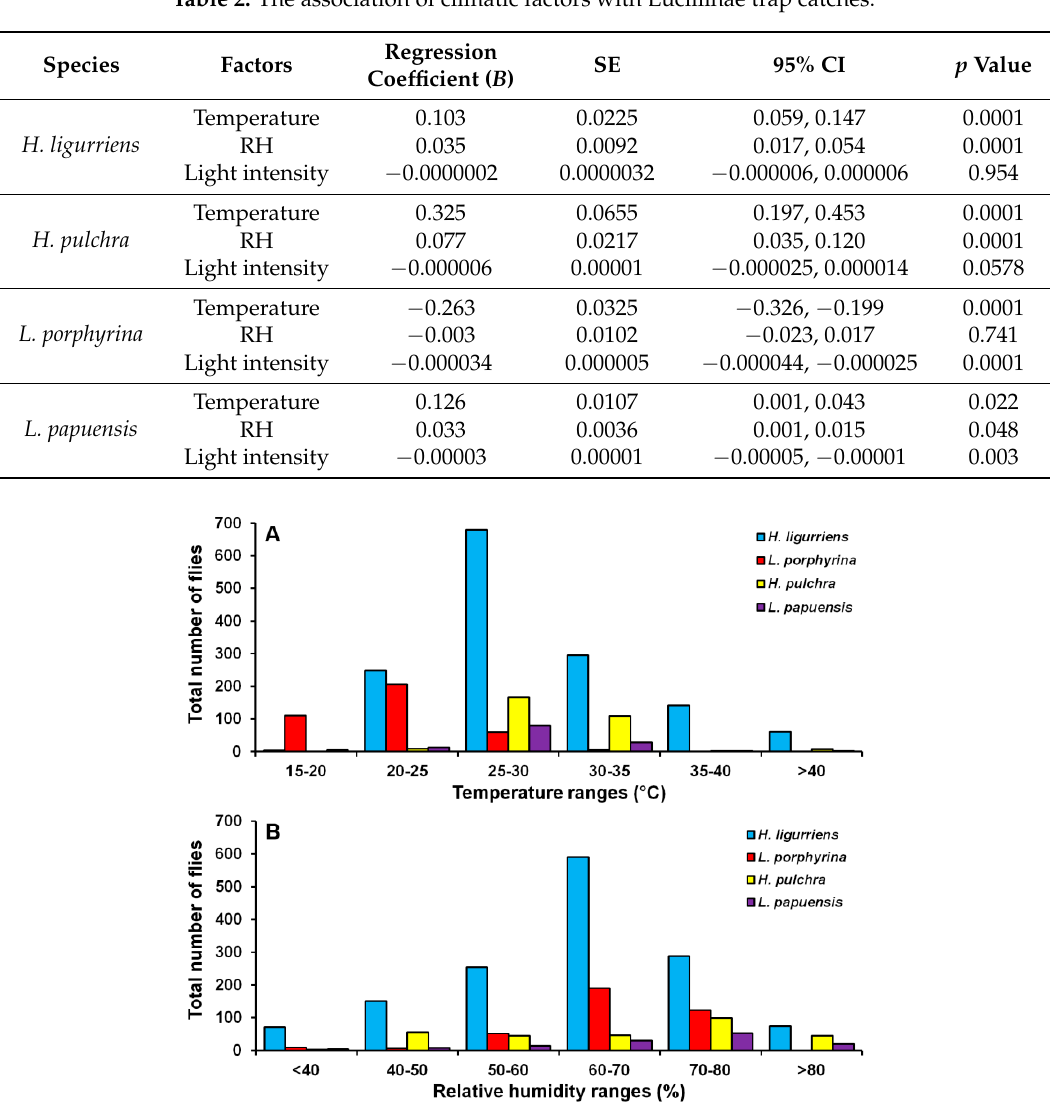
Table 2. The association of climatic factors with Luciliinae trap catches.